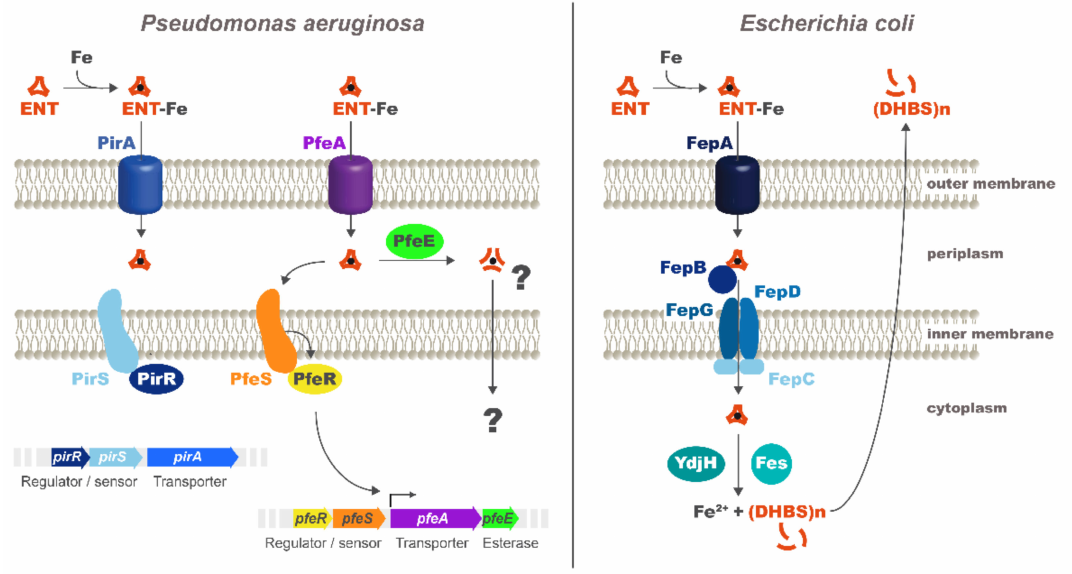
Figure 1. Iron uptake pathway via the siderophore enterobactin (ENT) in P. aeruginosa and E. coli . For more details, see the